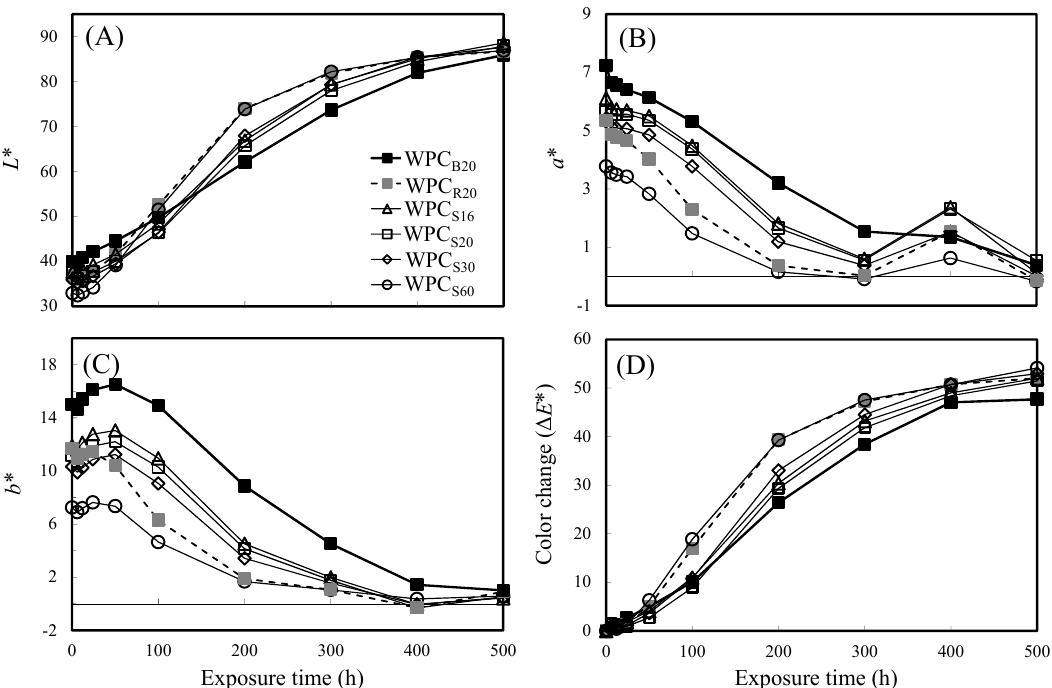
Figure 2. The color change of various WPCs during xenon arc accelerated weathering. ( A ) L* , ( B ) a* , ( C ) b* , and ( D ) Δ E * values. Each reported value is the average of five replicate specimens for each formulation.